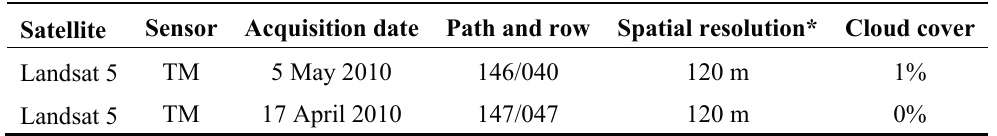
Table 1. Details of the satellite images